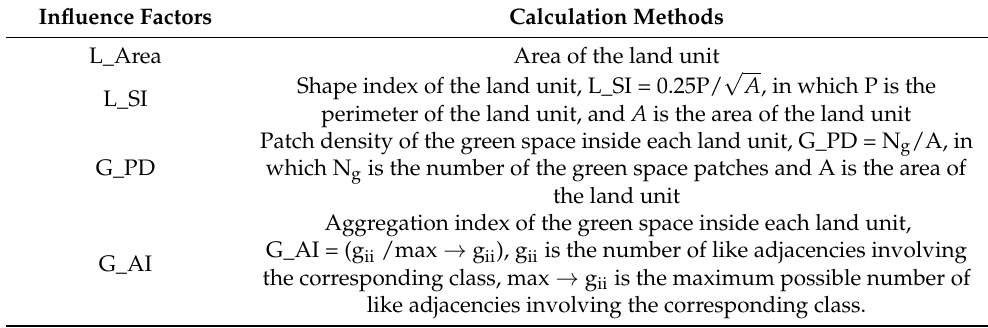
Table 4. The calculation methods of influence